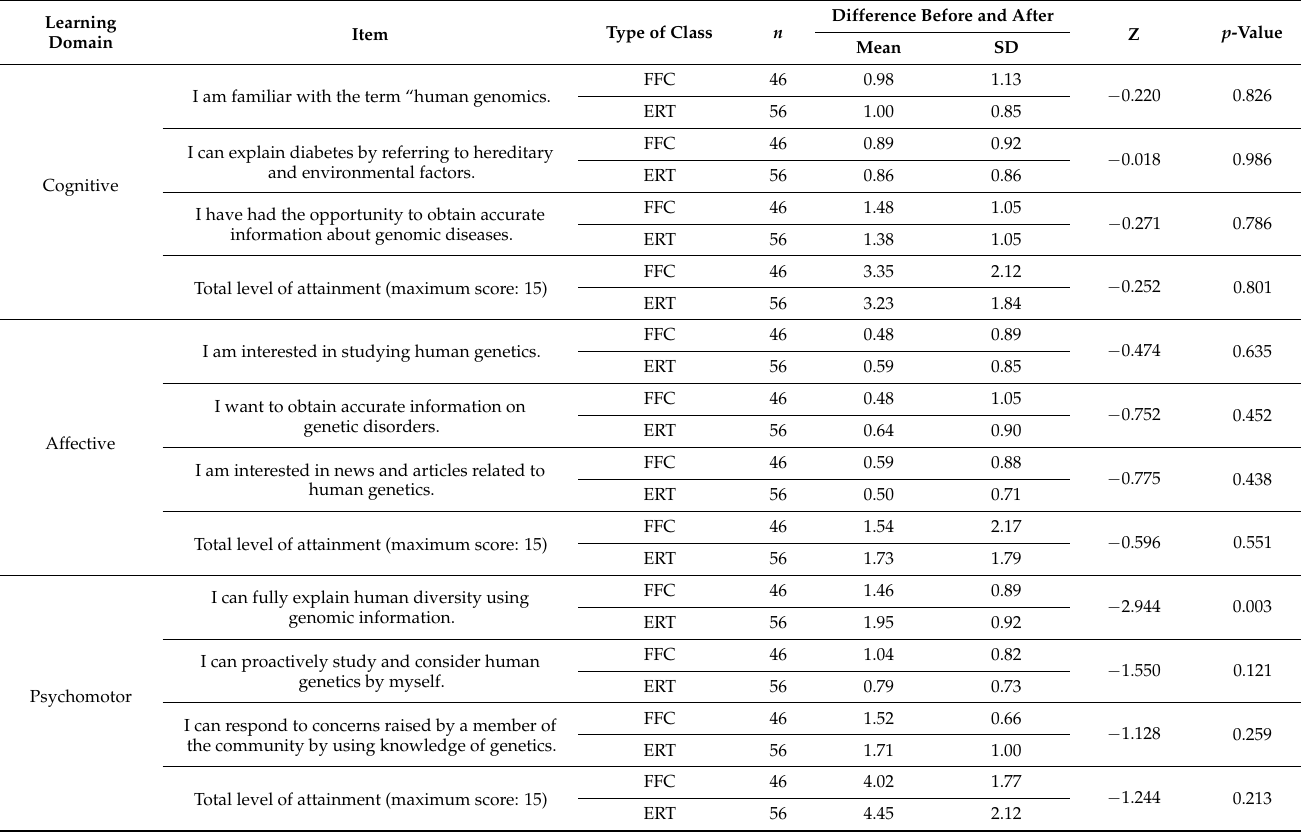
Table 3. Differences in effectiveness by type of class (differences between before and after goal attainment scores). Learning Domain